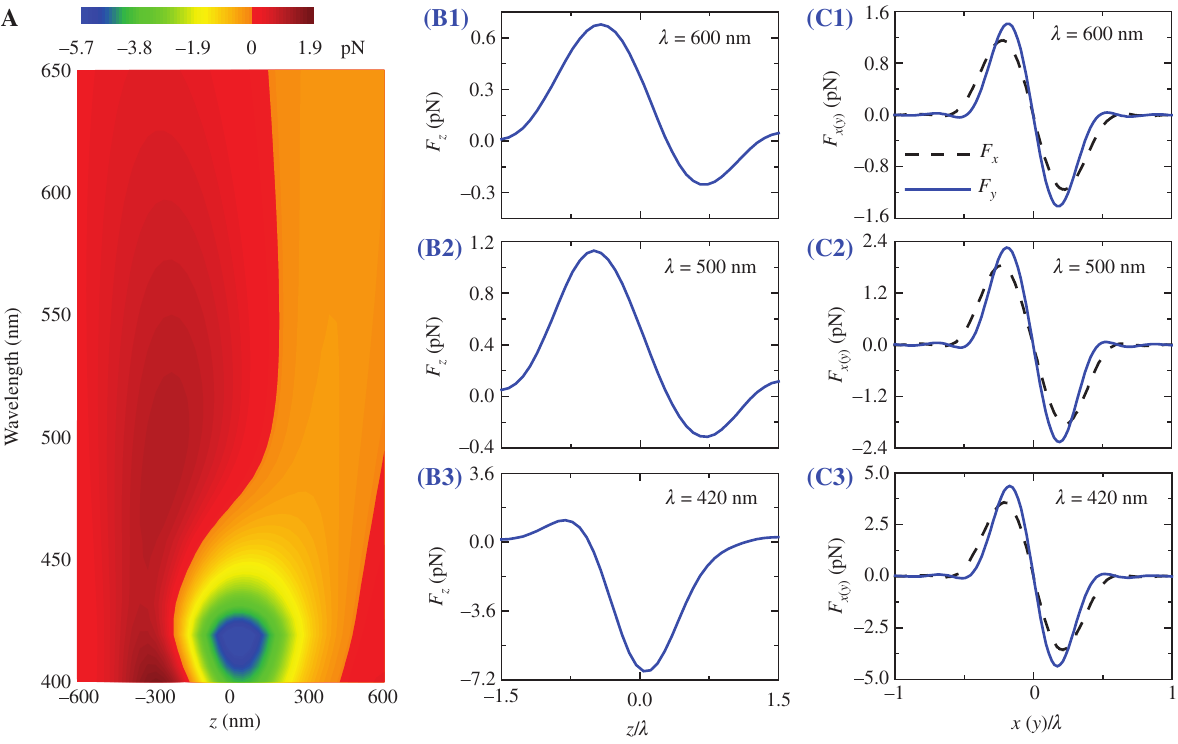
N nanoparticle immersed in CS 3 4